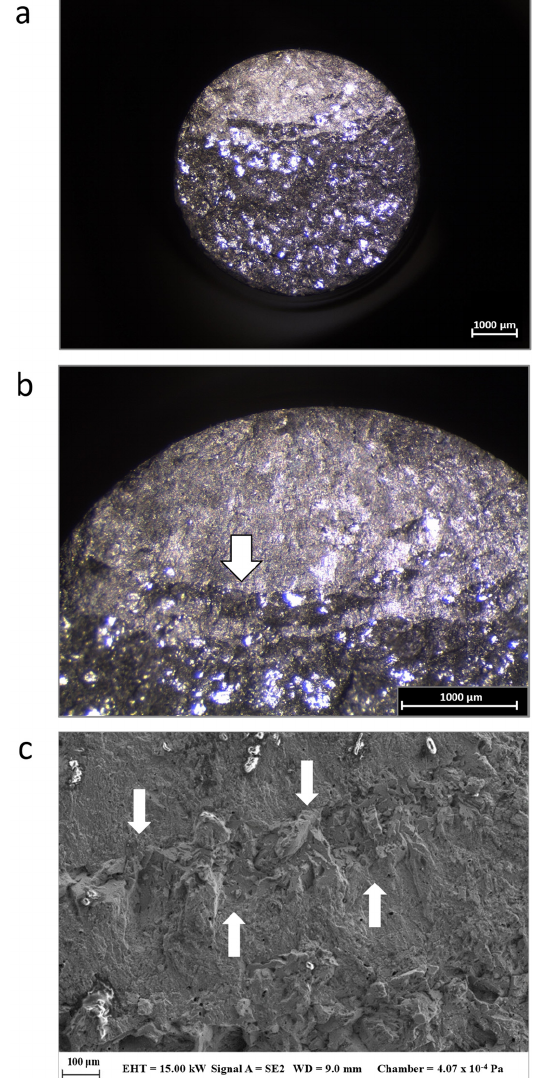
Figure 9. Surface fracture analysis: ( a ) example of final fracture surface for the untreated specimen, stereoscopic image 10×; ( b ) 25×; ( c ) detail of the morphology of the broken crash area within the fatigue propagation zone (identified by the white arrow in ( b )).